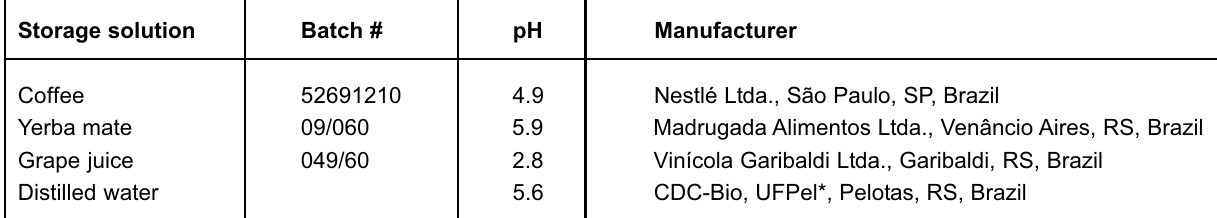
FIGURE 1- Type, batch number, pH and manufacturers of the immersion solutions *Development and Control Center Biomaterials, Dental School, Federal University of